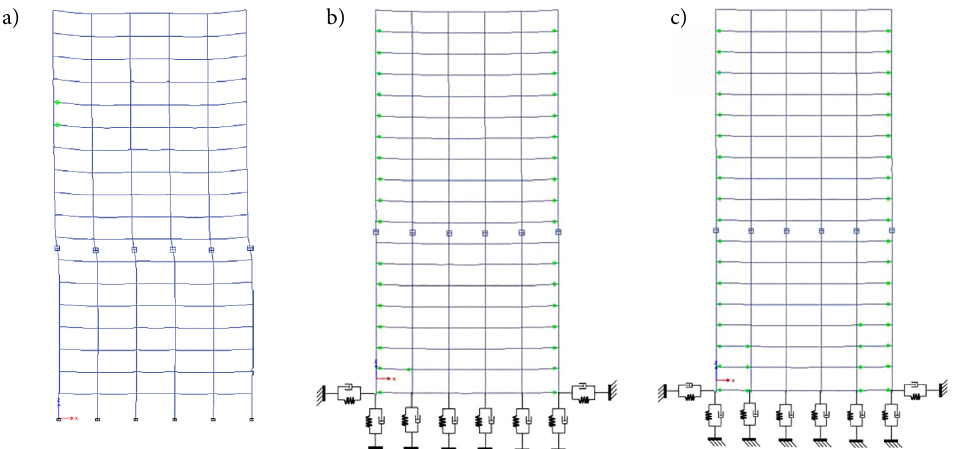
Figure 14. Comparison of plastic hinges situation (Green dots are plastic hinges): a – the plastic hinge situation of frame without considering the SSI effect; b – the plastic hinge situation of frame considering SSI effect (hard soil); c – the plastic hinged situation of frame considering SSI effect (soft soil)